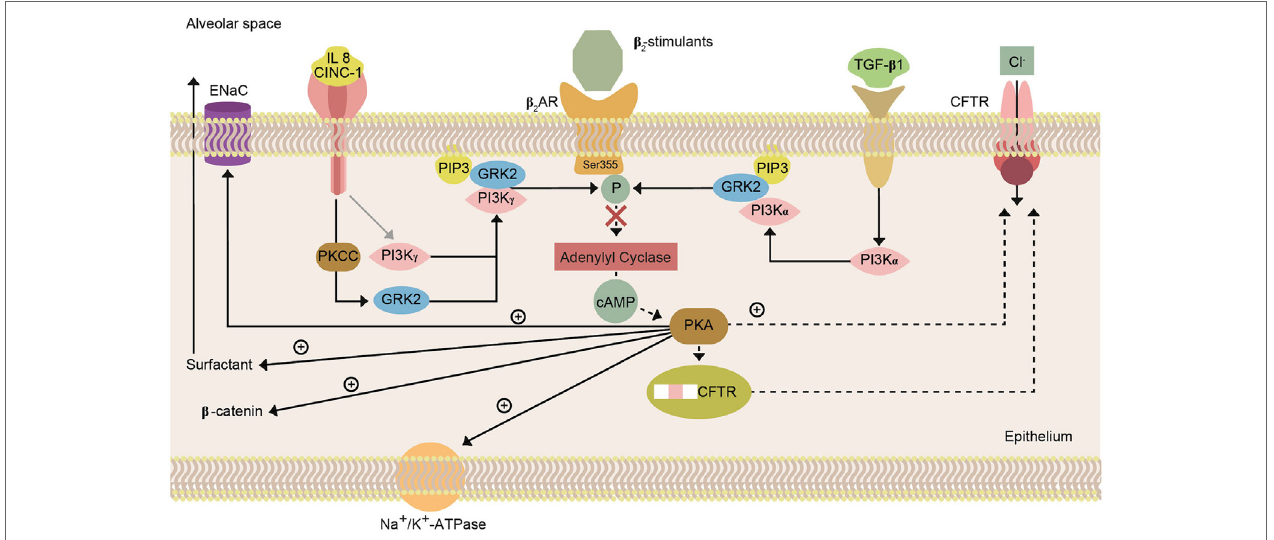
FigURe 8 | Rationale for the problematic role of β 2 adrenergic agonists in clinical trials. Schematic representation of the mechanisms by which interleukin-8 (IL-8)/ cytokine-induced neutrophil chemokine (CINC)-1 and transforming growth factor (TGF)- β 1 have a synergistic inhibitory effect on the β 2-adrenergic receptor ( β 2AR) signaling pathway in type II alveolar (ATII) cells. IL-8/CINC-1 and TGF- β 1 cause the activation of different phosphoinositide 3-kinase (PI3K) isoforms. However, IL-8/ CINC-1 but not TGF- β 1 phosphorylates G-protein-coupled receptor kinase 2 (GRK2) via a protein kinase C-zeta (PKC- ζ )-dependent mechanism explaining why the blockade of IL-8/CINC-1 prevents the TGF- β 1-mediated inhibition of the β 2AR signaling pathway in ATII cells. This results in the translocation of the protein complex GRK2 and PI3K to the cell membrane. This protein complex causes phosphorylation at the Ser355 heterologous desensitization and downregulation of the β 2AR in ATII cells. IL-8/CINC-1 and TGF- β 1 then prevent the activation of 3 ′ -5 ′ -cyclic adenosine monophosphate (cAMP)/protein kinase A (PKA) pathway that upregulates the vectorial fluid transport across the alveolar epithelium via phosphorylation and increased expression of cystic fibrosis transmembrane conductance regulator (CFTR) at the plasma membrane of ATII cells. The solid lines indicate the pathways stimulated by IL-8/CINC-1 and the dashed lines indicate the pathways inhibited by these mediators